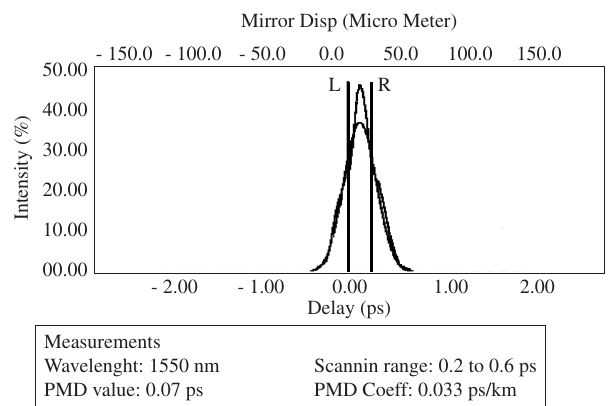
Figure 3. The differential group delay in PMD using interferometric